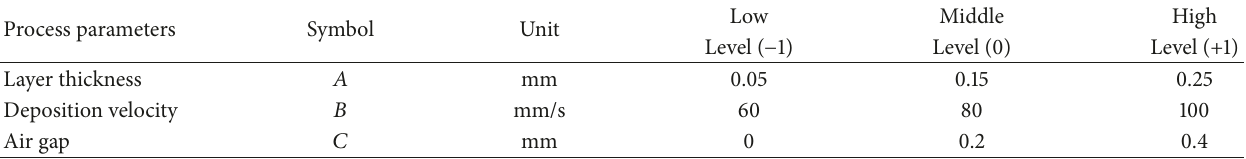
Table 1: The fabrication parameters and the setting of values of the parameters under disparate levels.